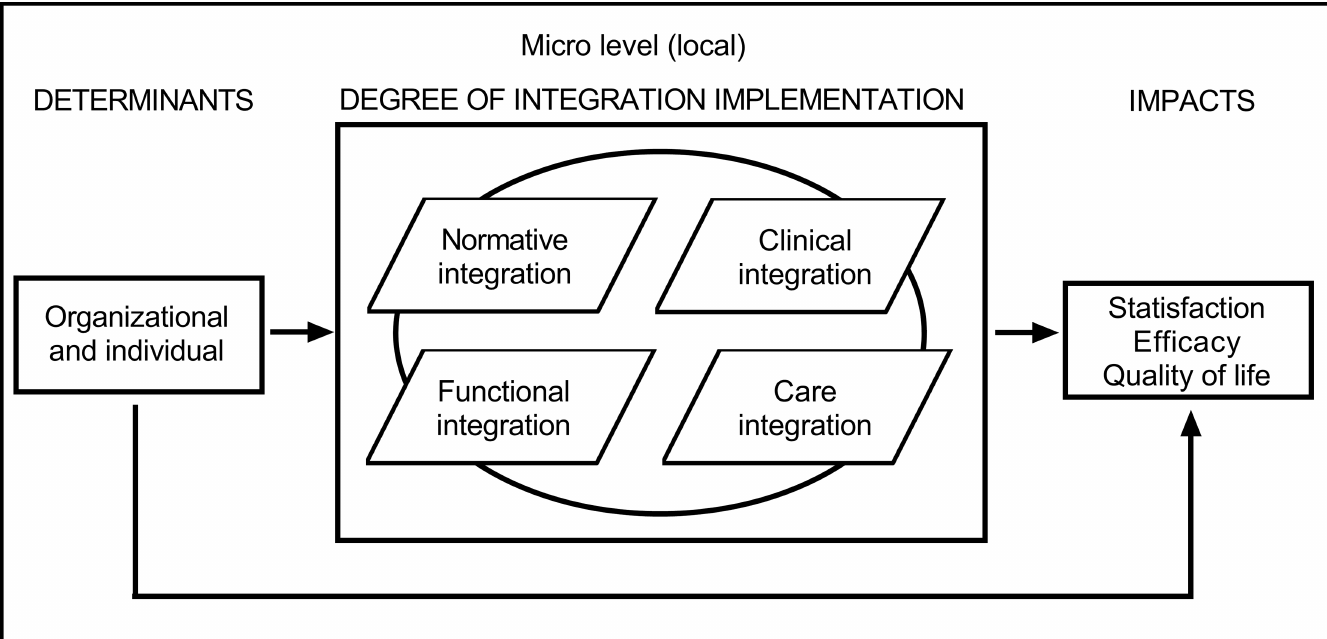
Fig 1. Conceptual framework for the analysis of integration implementation in the healthcare process, taken from Roberge et al. [15] and adapted from the model by Contandriopoulos et al. [14].